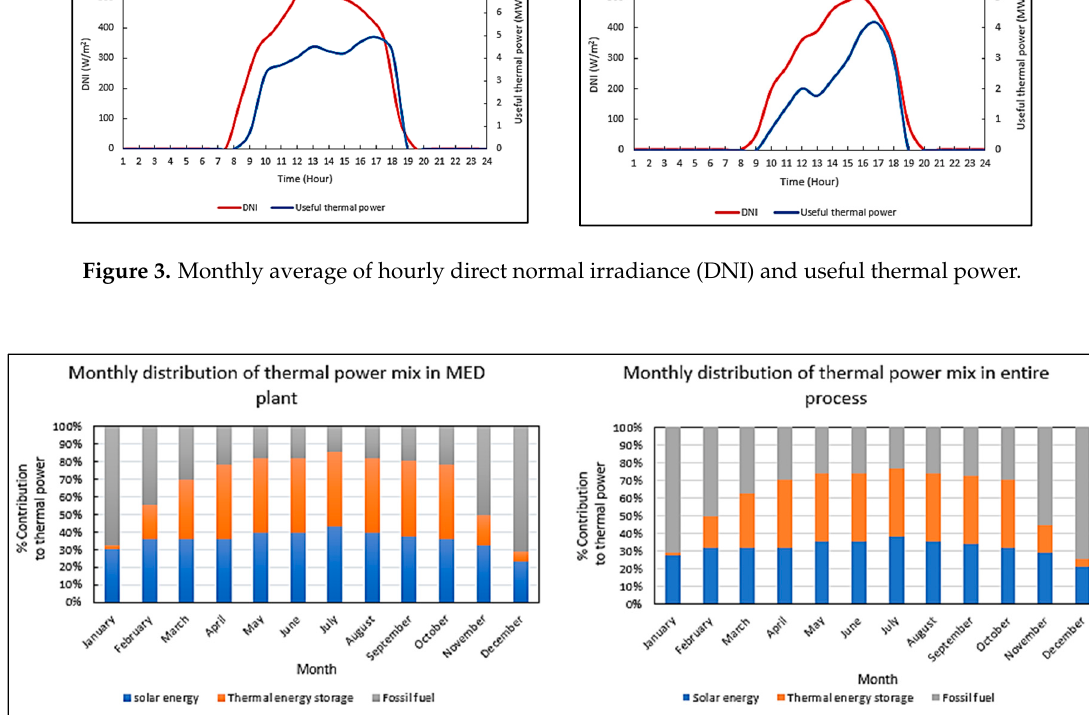
Processes 2018 , 6 , x FOR PEER REVIEW Figure 4. Optimal thermal power mix for MED plant and the entire system with 30% RO 70% MED .